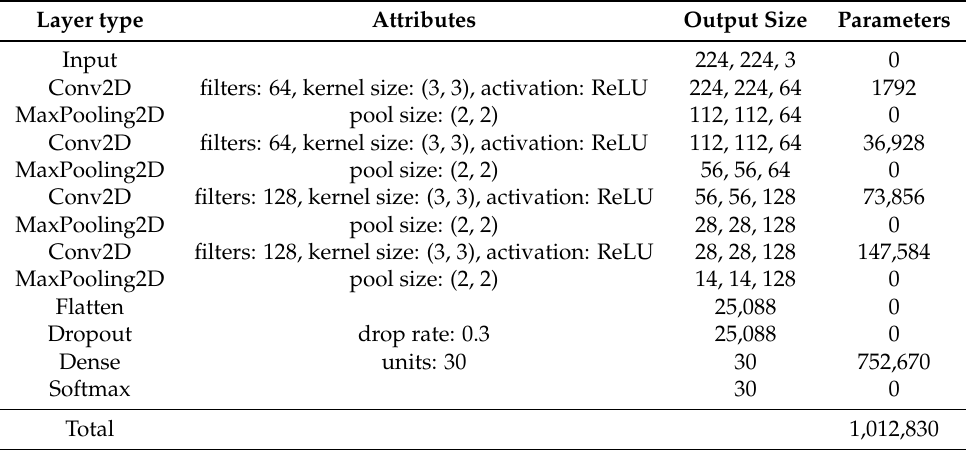
Table A1. The structure of the student CNN model in experiments on AID dataset.